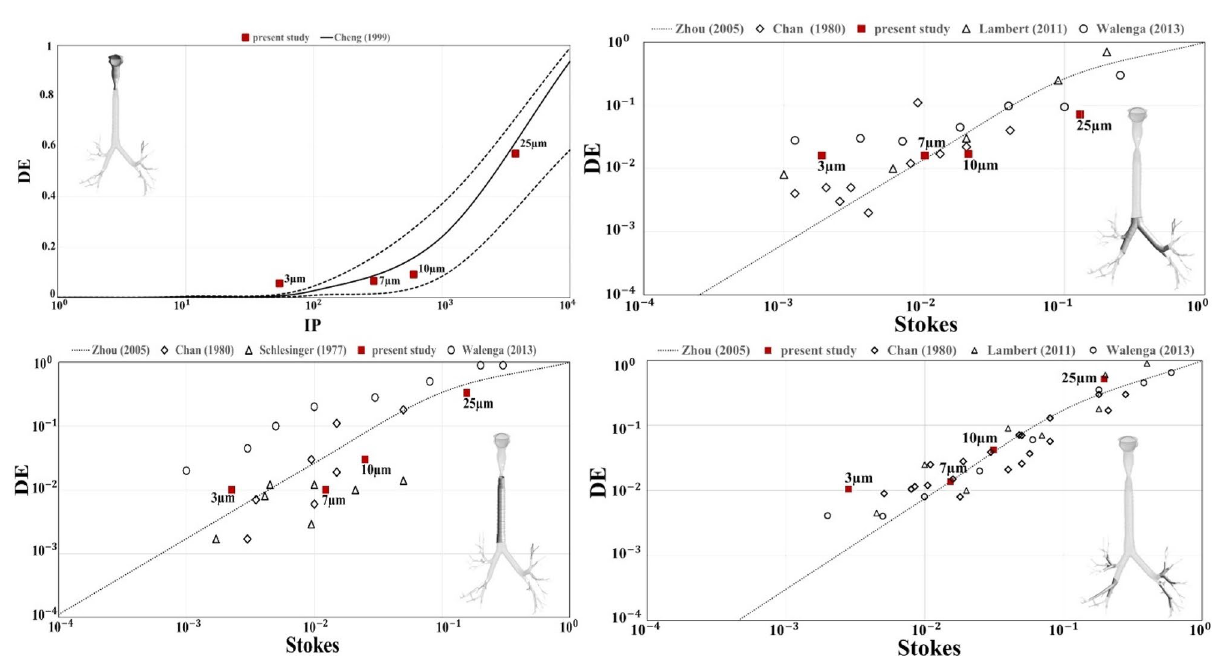
Figure 5. Deposition efficiency (DE) of 3–25 µm particles injected under steady conditions (Q = 6 L/min). RUL and RLL are the right upper and lower lobes, LUL and LLL are the left upper and lower ones. DE in the upper airways is presented as a function of the impaction parameter IP (Eq. 1), while the Stokes number (Eq. 7) better represents the DE behaviour in downstream